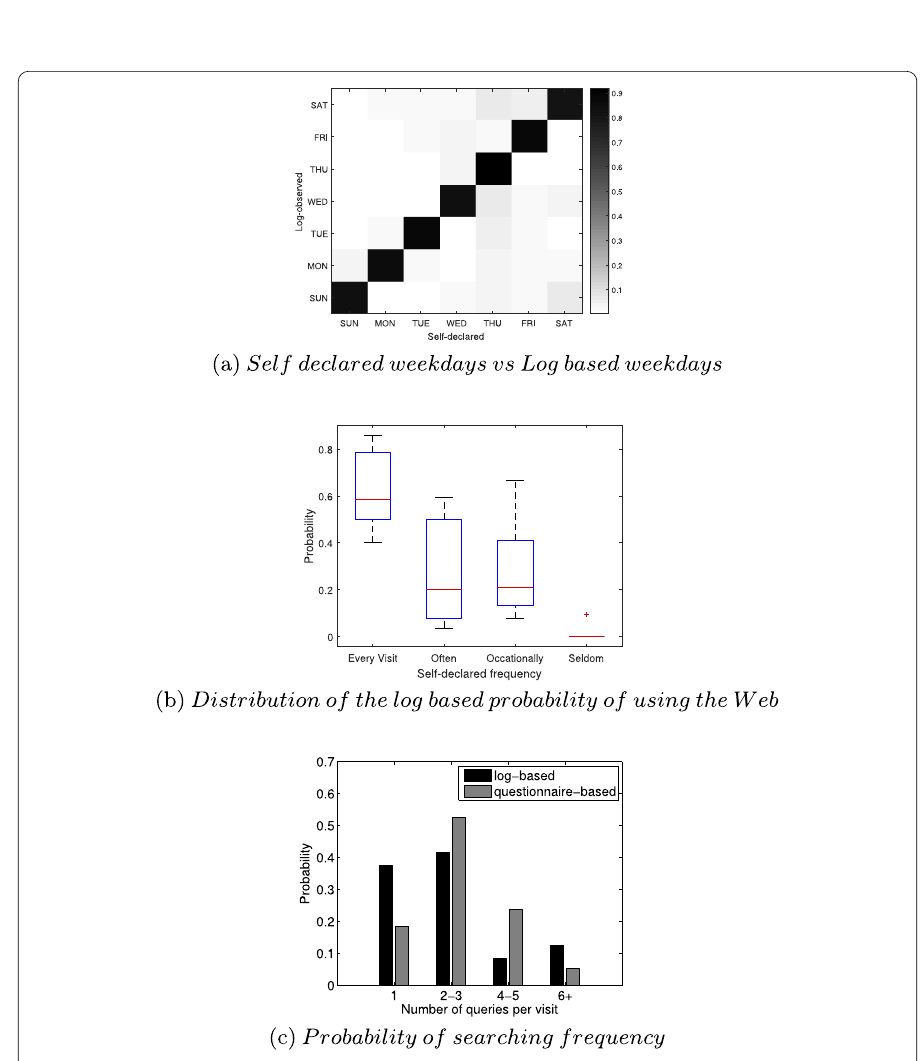
Figure 3 (a) The self-declared weekdays vs the log-based one, where the size of the circle denotes the probability of a log-based visit happened on a self-declared day; (b) The distribution of the log-based probability of using the Web for each self-declared frequency; (c) The self-declared searching frequency vs the log-based